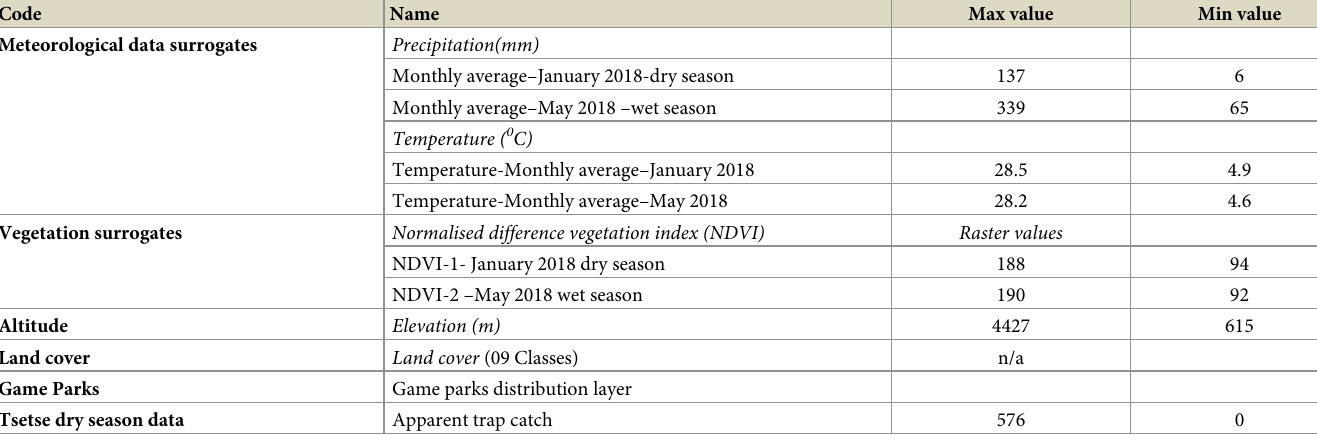
Table 1. Predictor variables used in the analyses of tsetse fly abundance including their observed maximum and minimum values in the training dataset.